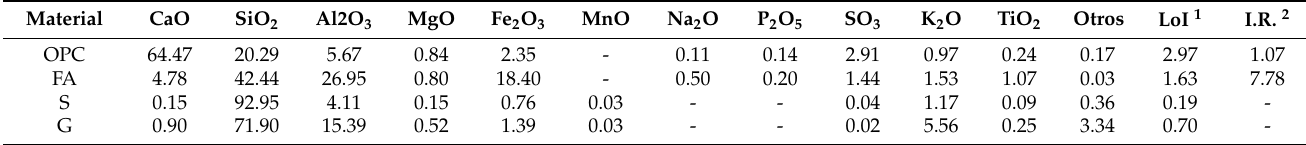
Table 1. Chemical composition of OPC, FA and sands S and G (% wt.).